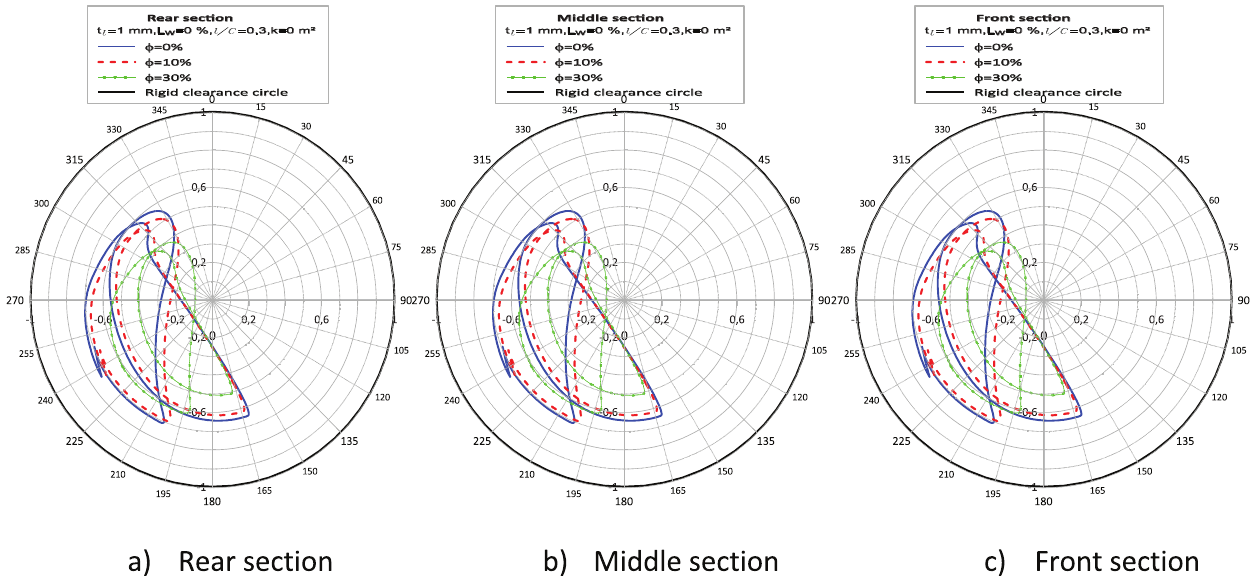
Fig. 19. Effects of the NPs concentration parameter, f , on the stationary journal center orbits for the deformable